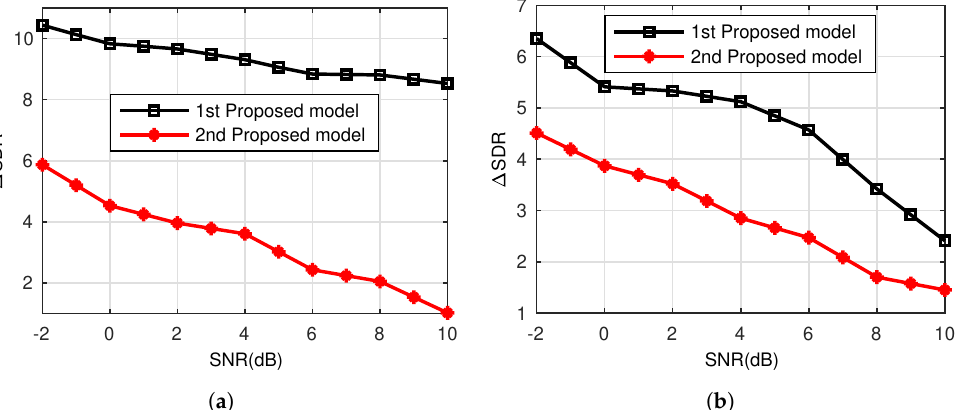
Figure 9. ( a ) Comparison of the two proposed models for ˆ S 1 with variable SNR (dB); ( b ) Comparison of the two proposed models for ˆ S 2 with variable SNR